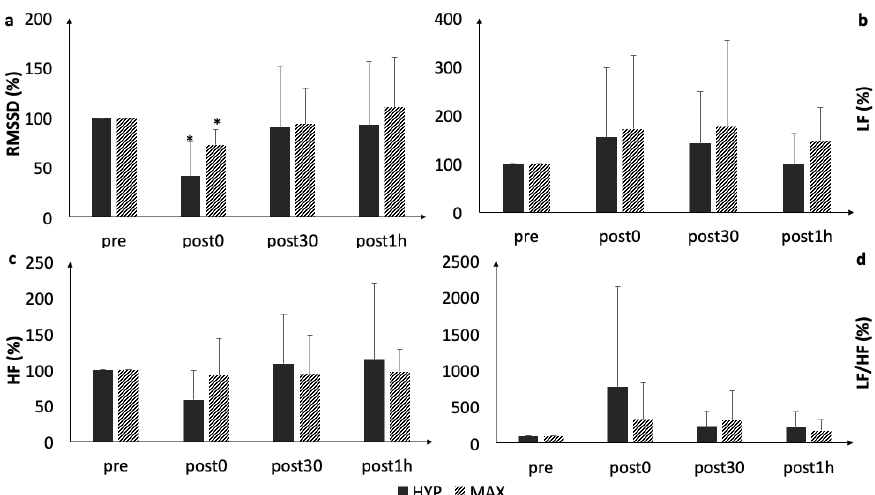
Table 1. Effect sizes (ES) between MAX and HYP for each acute time point in relation to the corresponding pre